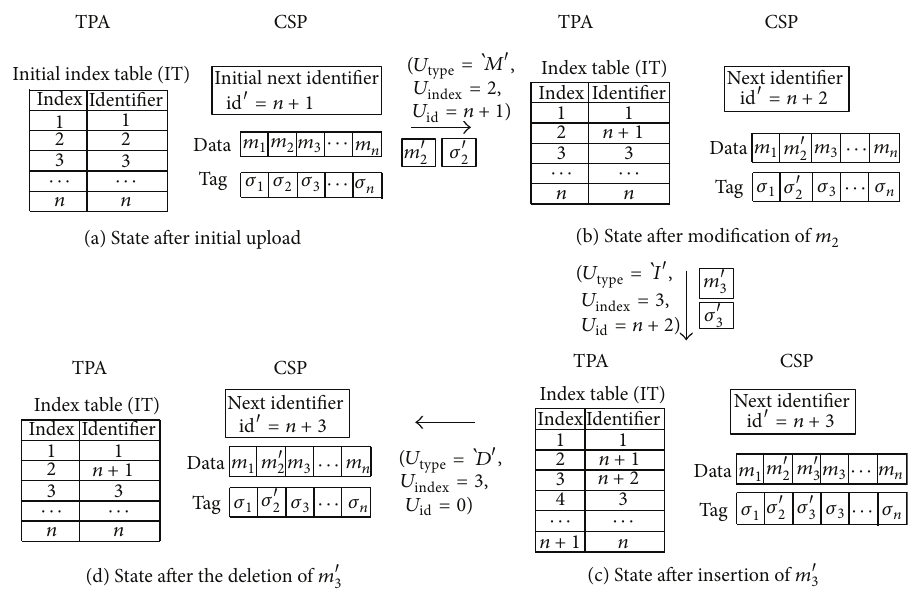
Figure 6: Examples of data